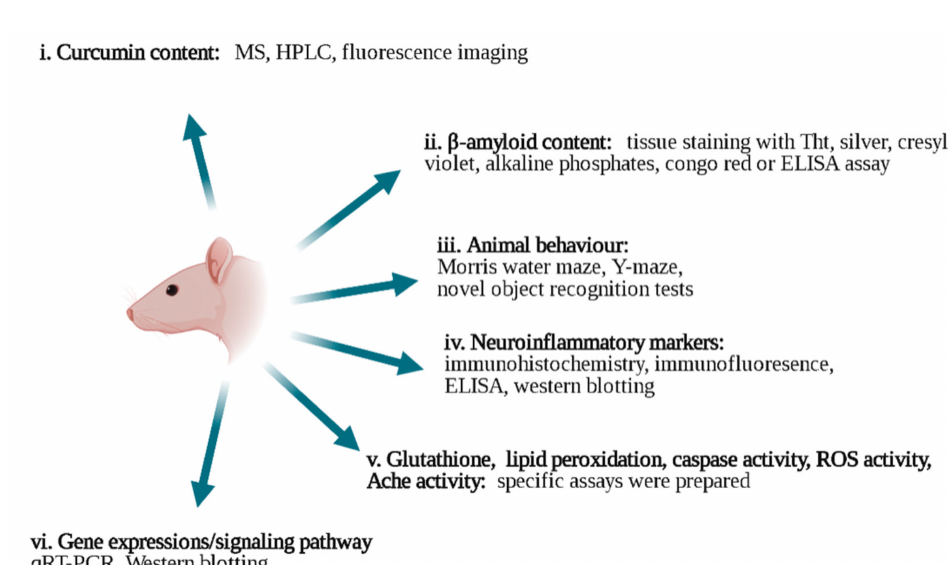
Figure 1. In vivo characterization techniques applied to study the effects of curcumin on AD (drawn in Biorender). i . Curcumin content: MS [6], HPLC [58,59,75], and fluorescence imaging [21,41] techniques. ii . β -amyloid content: thioflavin T (Tht) staining [61,76–79] silver staining [39,80], cresyl violet [81], alkaline phosphates [82,83], congo red [78,79], and ELISA assay [2,18,84]. iii . Animal be- havior tests: Morris water maze [32,39,85], Y-maze [5,86,87], and novel object recognition tests [5,66]. iv . Neuroinflammatory markers: immunohistochemistry [87–90], Western blotting [91], qRT-PCR analysis [91,92] and ELISA assay [86,92]. v . Glutathione [3,93], lipid peroxidation [56,87], caspase activity [94,95], ROS activity [96], Ache activity [97–99] assays were used. vi . Gene expressions and signaling pathways: qRT-PCR [84,100] and Western blotting